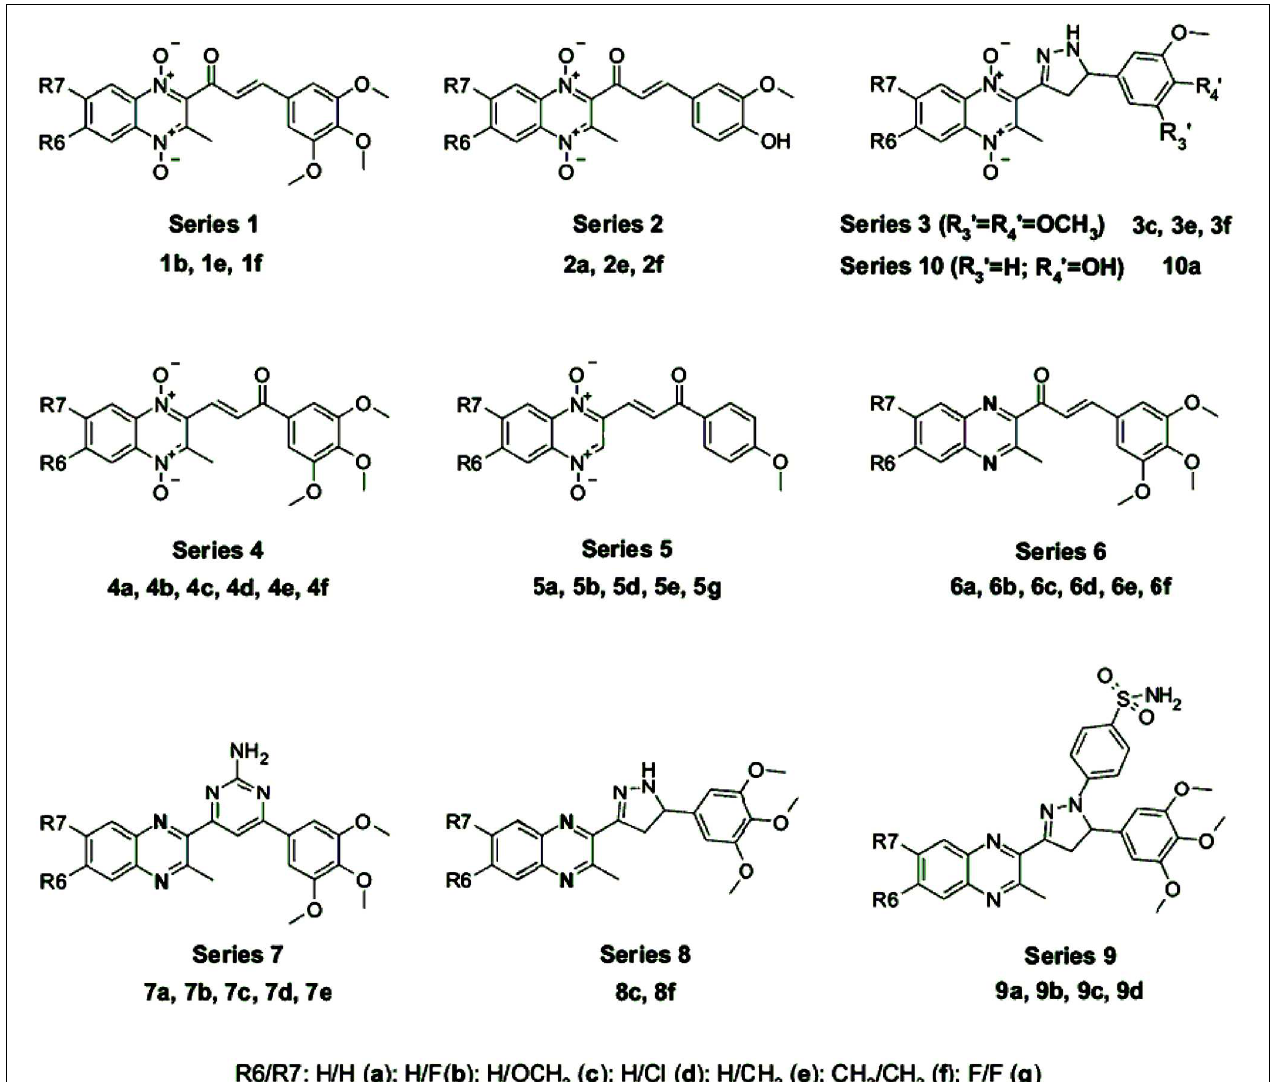
FIGURE 12 | QdNOs with antiinflammatory and antioxidant activities [adapted from Burguete et al.